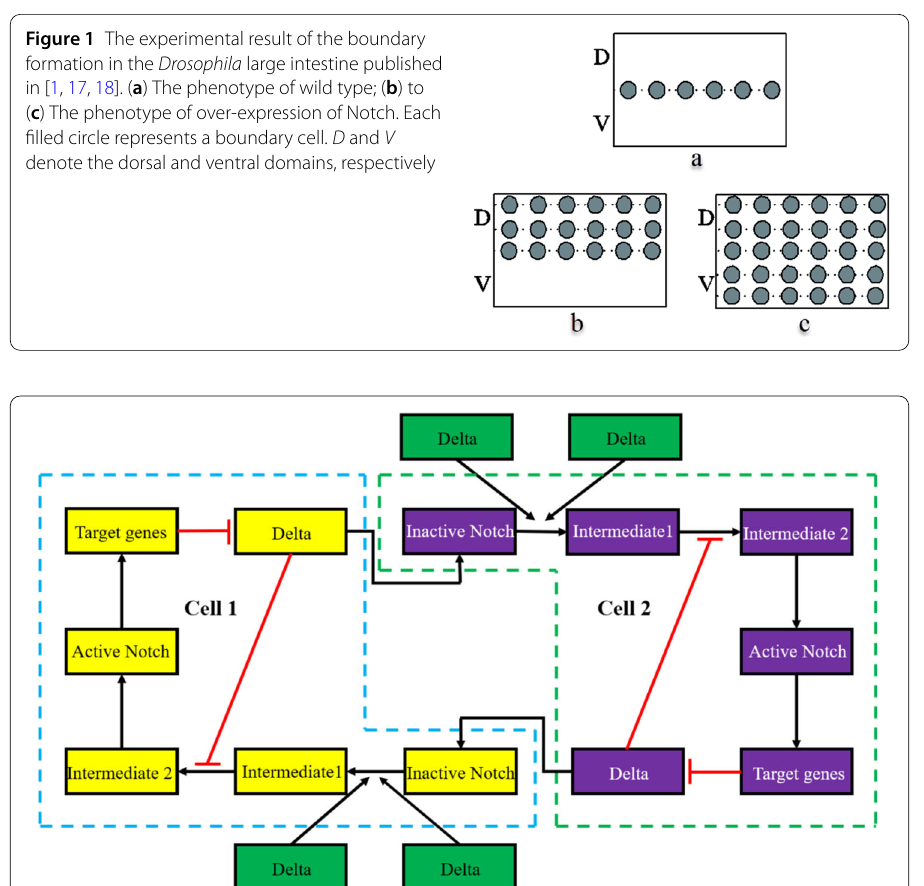
Figure 1 The experimental result of the boundary formation in the Drosophila large intestine published in [1, 17, 18]. ( a ) The phenotype of wild type; ( b ) to ( c ) The phenotype of over-expression of Notch. Each filled circle represents a boundary cell. D and V denote the dorsal and ventral domains,